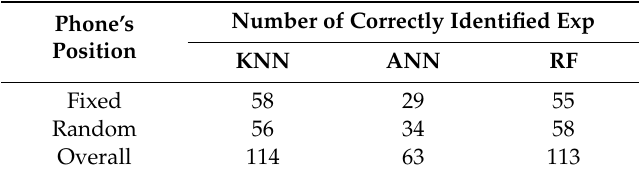
Table 5. Performance of parking/unparking detection for the classifiers.